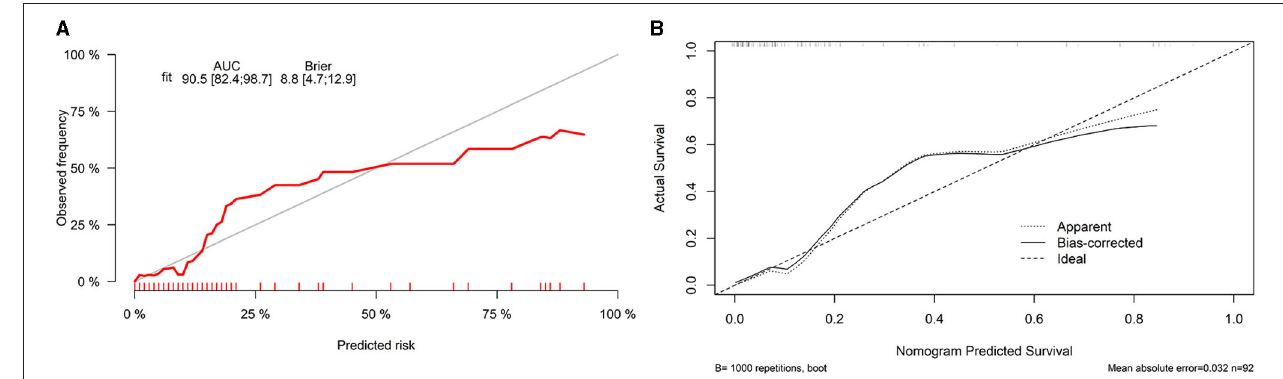
FIGURE 2 | Discrimination and calibration of a nomogram. (A) Concordance index (C-index) and (B) calibration curve. Among 76 relapsed patients and 16 non-relapsed patients, 75 and 12 patients were positive for HBeAg, respectively ( p = 0.003).